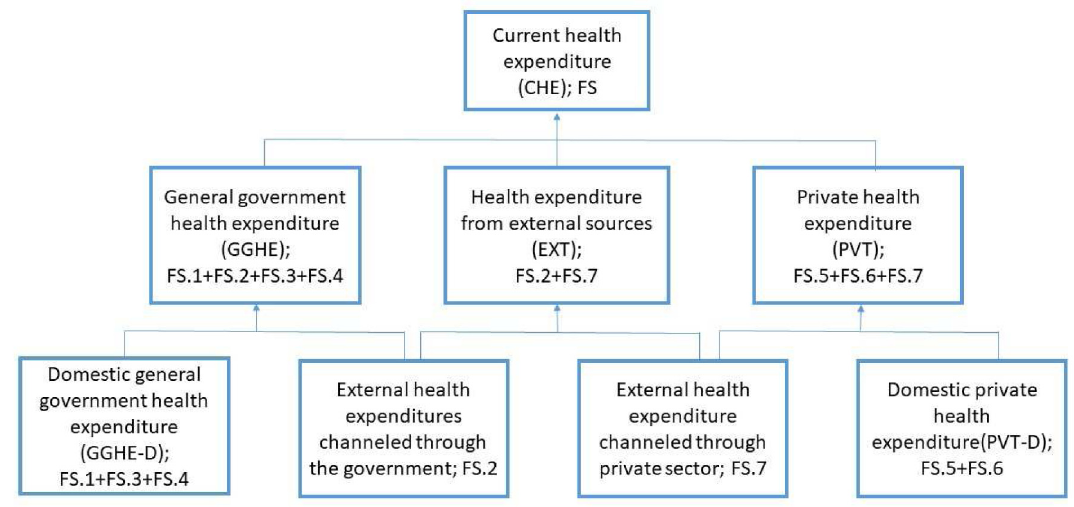
Figure 1. Sources of health expenditures reported in the Global Health Expenditure